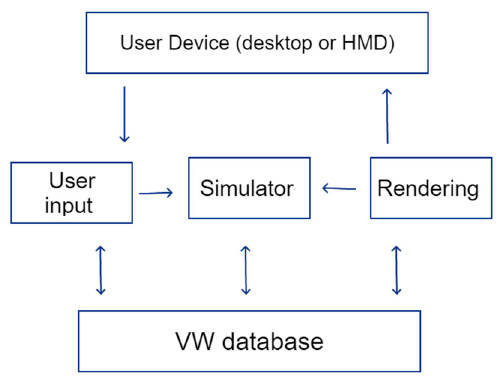
Figure 5. Virtual world system design with XR interface.